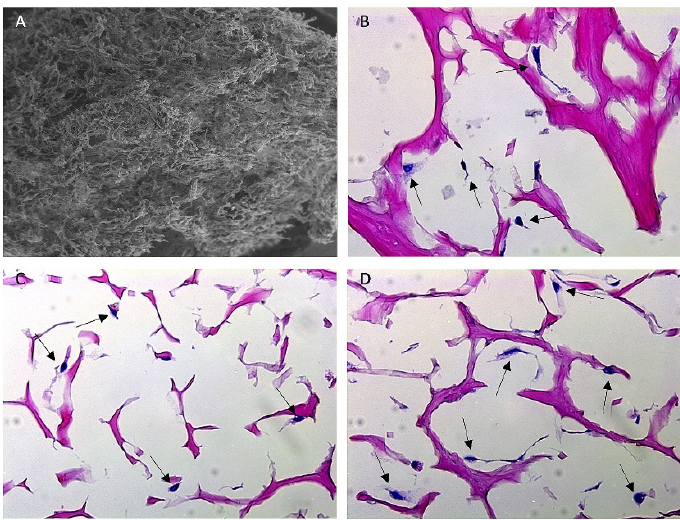
Figure 4. SEM and H&E-stained histology images of Fibro-Gide ® collagen matrix. ( A ) SEM image of Fibro-Gide ® cylinder. ( B – D ) Histology images taken at 40× magnification of Fibro-Gide ® seeded with MC3T3-E1 cells on days 3 ( B ), 5 ( C ), 7 ( D ) of cell culture. Dark pink material is collagen matrix, dark purple material is cell nuclei, denoted by black arrows.